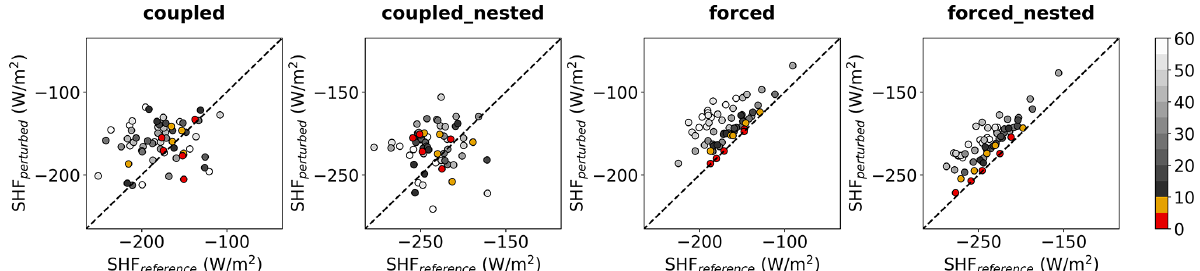
Figure 15. Changes in surface heat flux (SHF) due to the freshwater perturbation. SHF is averaged over the ENA region (see Fig. 8) and over December to February (DJF). Circles for each of the first 62 years of the perturbed simulations vs. the respective years of the reference runs are displayed. Years 1–5 and 6–10 are highlighted in red and yellow, respectively. Axis scales are shifted by − 50Wm − 2 for the two nested configurations. The dashed line depicts the 1 : 1